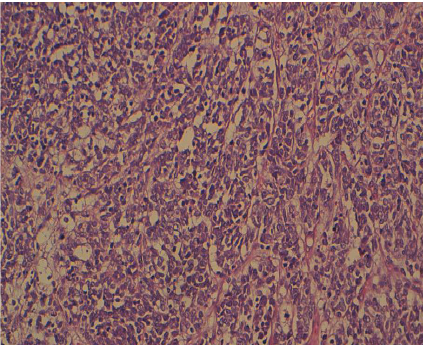
Figure 4: CT scan of the abdomen cut: showed a 50mm mass in the pancreatic body, suggestive of metastasis from a primary in the